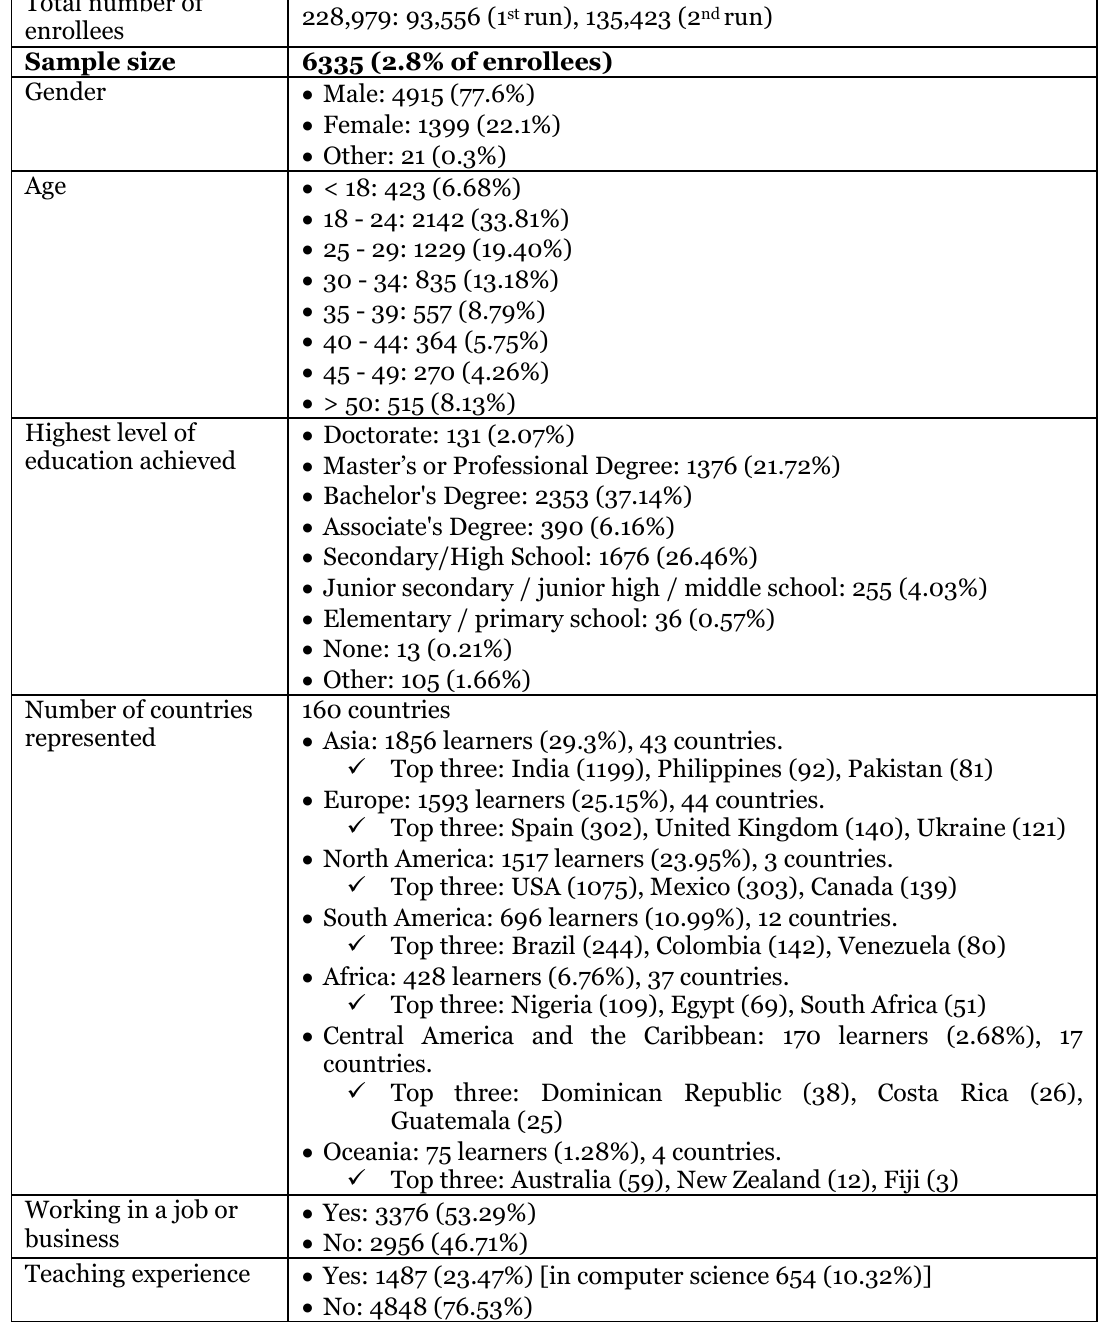
Sample Size and Self-Reported Demographics of Participants in the